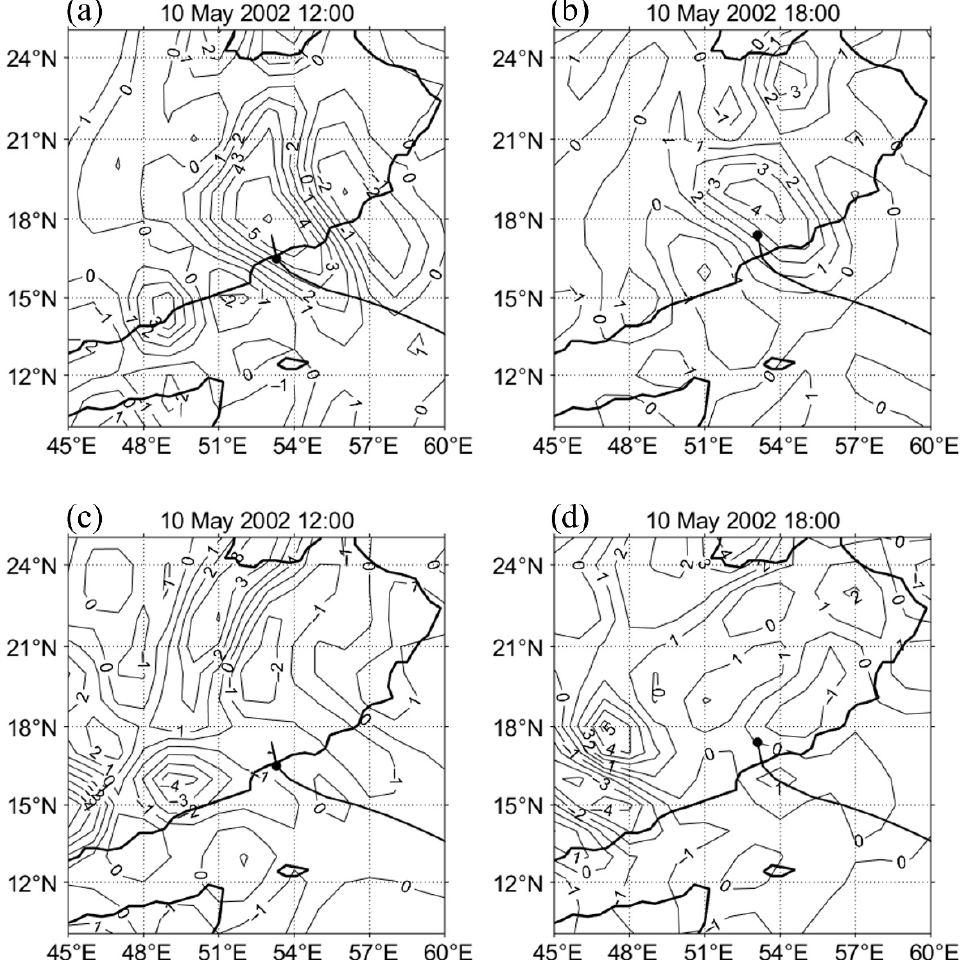
Figure 10. The divergence (10 − 5 s − 1 ) of ARB 01 during and after landfall. ( a ) 10 May 2002 12:00, ( b ) 10 May 2002 18:00 at level = 200 hPa; ( c ) 10 May 2002 12:00, ( d ) 10 May 2002 18:00 at level = 850 hPa. The black dot indicates the TC center.